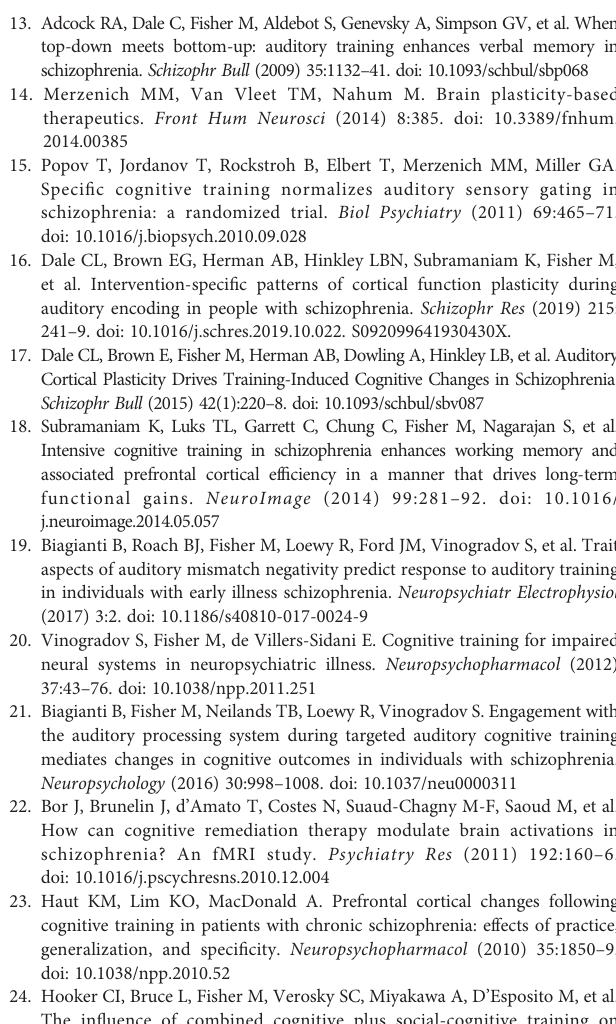
SUPPLEMENTARY TABLE 1 | Medication Regimens of Study